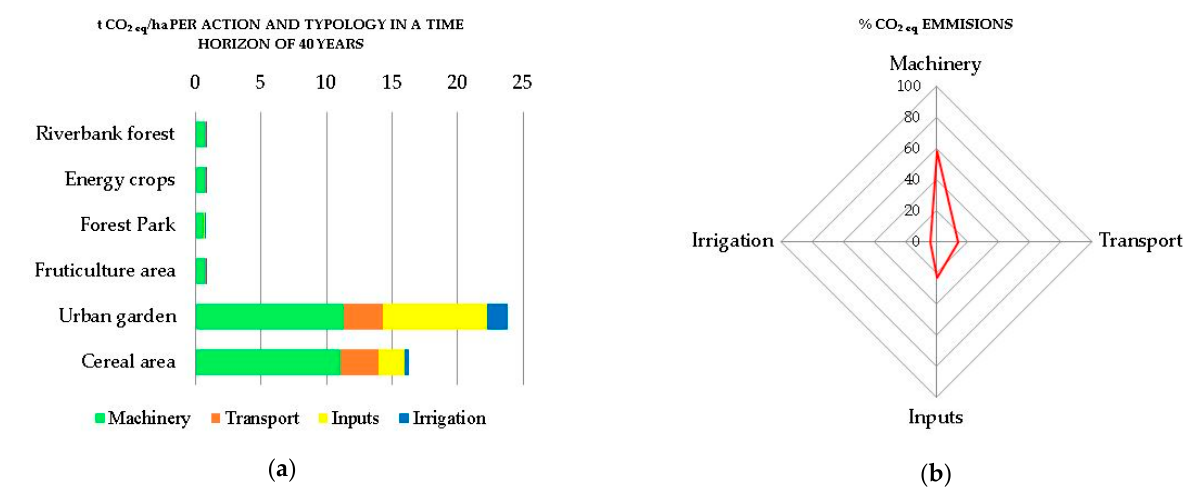
Figure 2. CO 2-eq emission due to implementation and maintenance of the forestry and agricultural actions included in the development of the urban green infrastructures (UGI) in a time horizon of 40 years: ( a ) t CO 2-eq /ha per action and typology; ( b ) % CO 2-eq emissions per action.